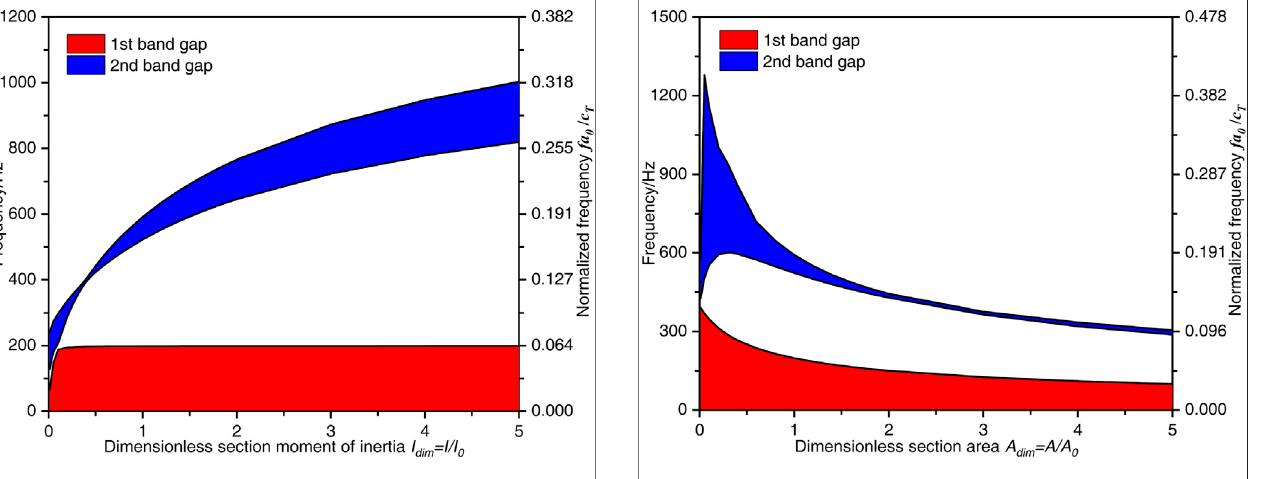
FIGURE 8 | The fl exural wave band gaps characteristics with different dimensionless section moment of inertia I dim parameters.